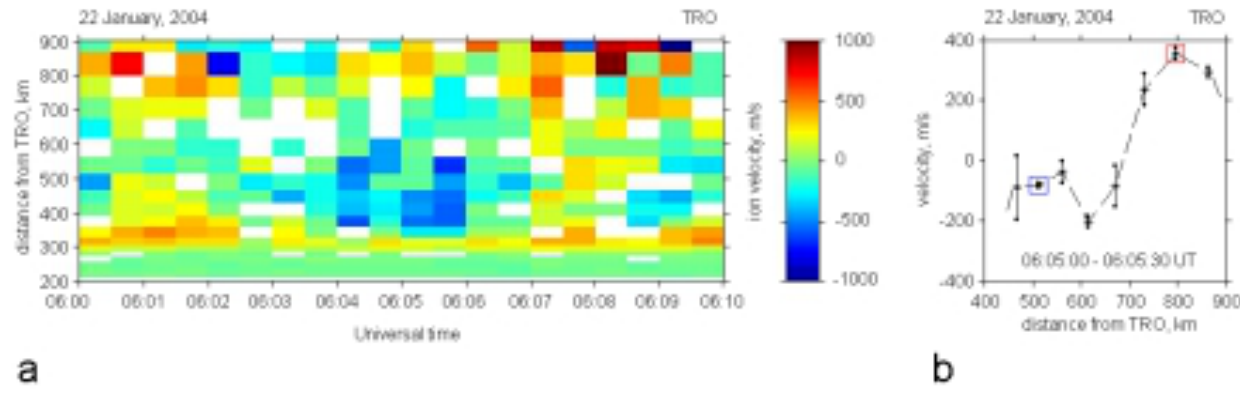
Fig. 10. (a) EISCAT UHF measurements of line-of-sight velocity in the vicinity of the westward torch border. Positive values correspond to a velocity toward the radar. (b) Distribution of l-o-s velocity along radar beam. The velocities plotted in Fig. 9 are here indicated with squares of the corresponding color.